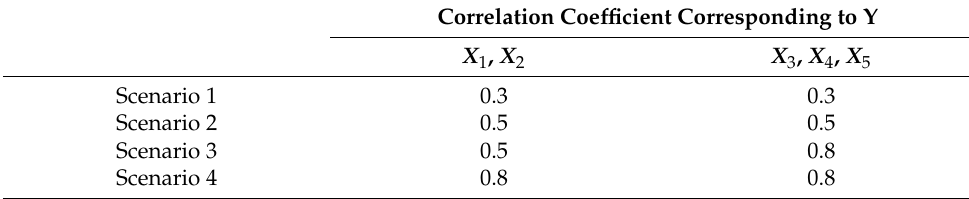
Table 1. Different correlation structures between Y and the predictors.